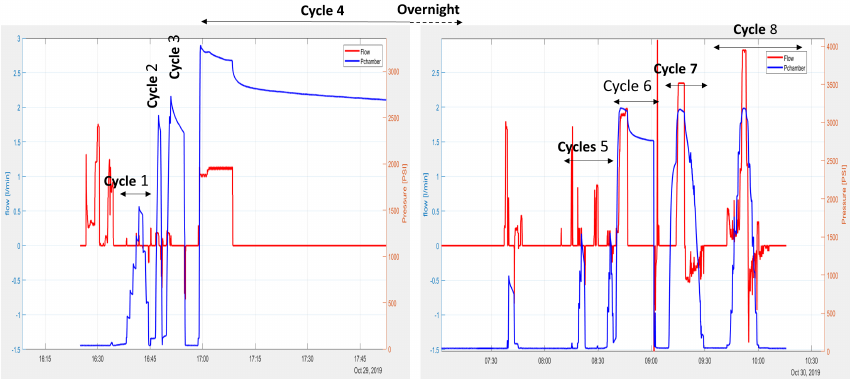
Figure 21. Borehole TV 4100 test 4 injection tests [47].